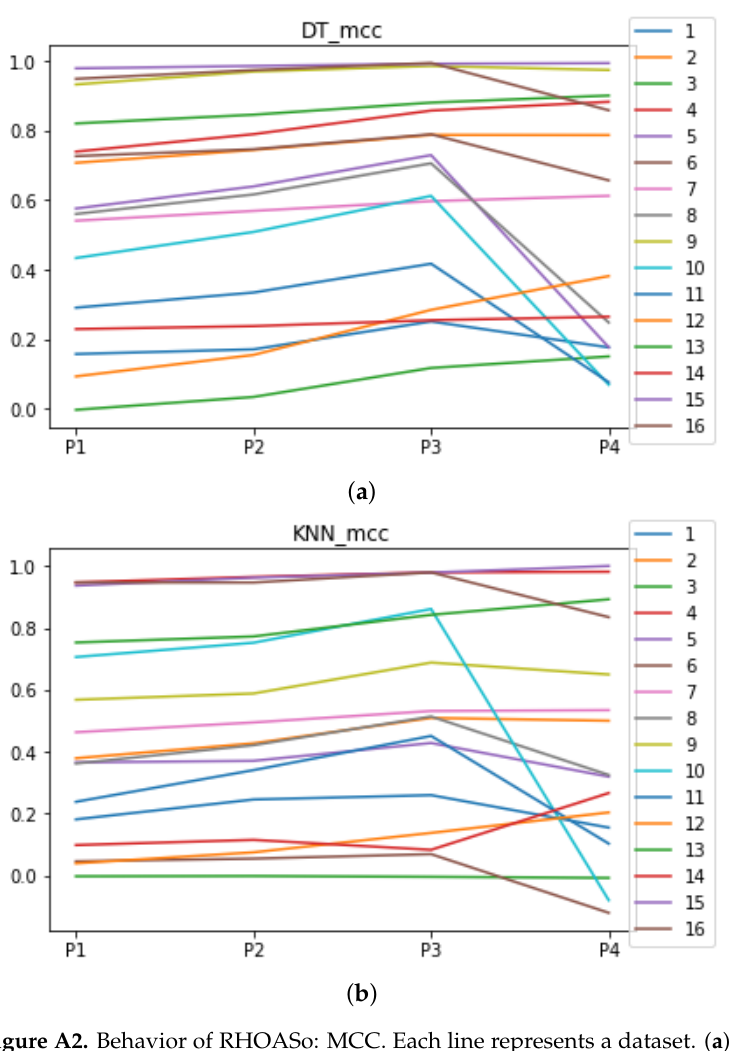
Figure A2. Behavior of RHOASo: MCC. Each line represents a dataset. ( a ) MCC for DT. ( b ) MCC for KNN.